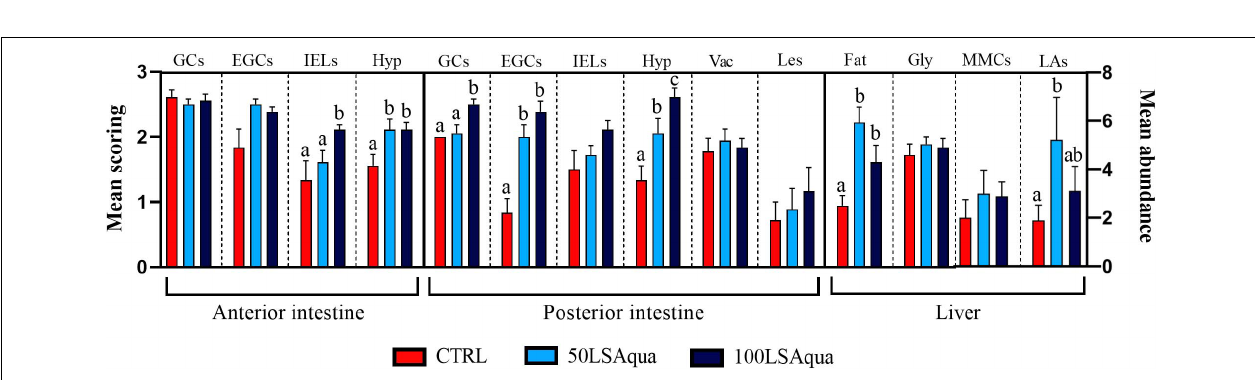
FIGURE 2 | Scoring of histological alterations in fish fed with control (CTRL), 50LSAqua and 100LSAqua diets. Mean semiquantitative scoring (+SEM) from 0 (absence) to 3 (very abundant) is shown for abundance of PAS + Goblet cells (GCs), eosinophilic granular cells (EGCs), and intraepithelial lymphocytes (IELs). Mean semiquantitative scoring (+SEM) from 0 (absence) to 3 (severe) is shown for the degree of hyperplasia in the submucosa (Hyp), vacuolization of enterocytes (Vac), epithelial lesions (Les), hepatic fat storage (Fat) and hepatic glycogen storage (Gly). Total melanomacrophage centers (MMCs) and lymphocyte aggregates (LAs) were quantified in livers (mean abundance + SEM). Different letters within each alteration indicate statistically significant differences among diets ( P < 0.05).